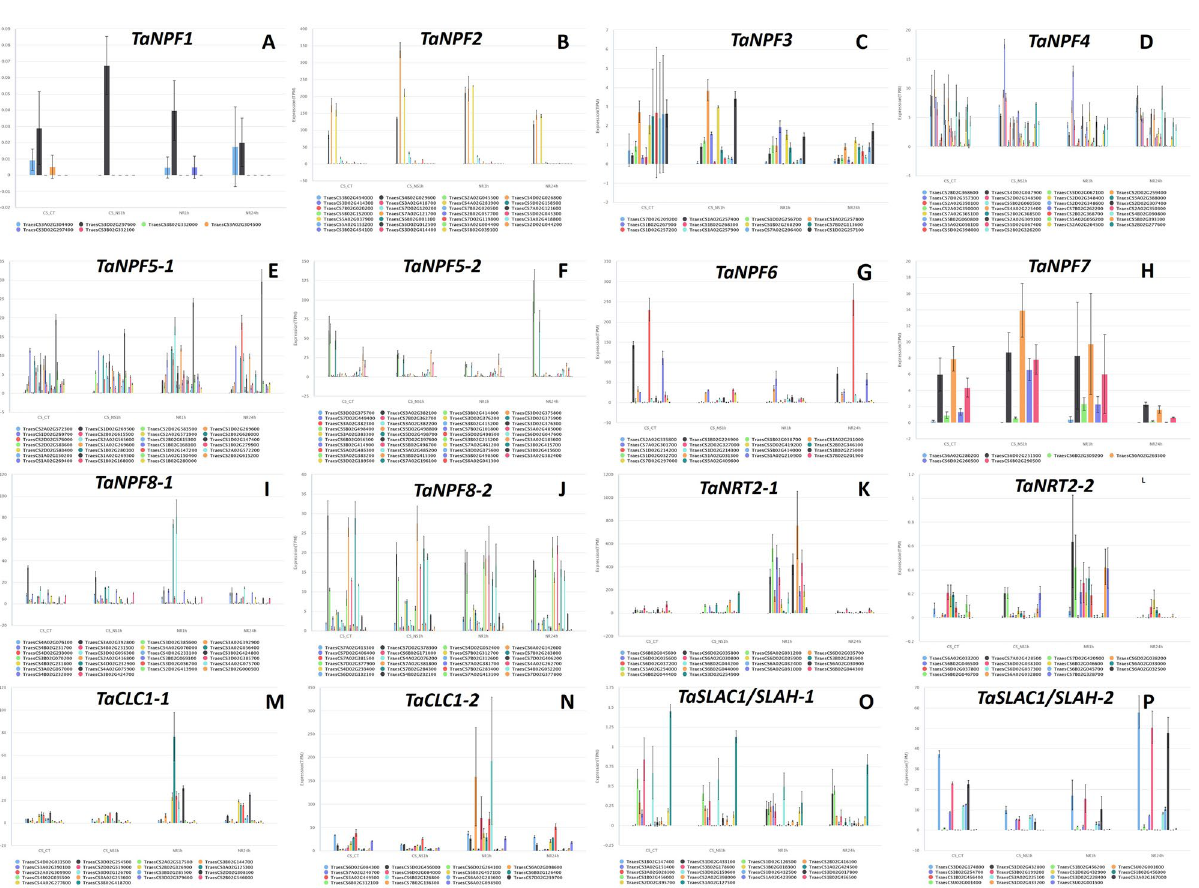
Figure 7. Expression profiles of nitrate transporter genes in response to Nitrogen starvation and Nitrogen recovery. The graphs were generated by GeneExpression tool from WheatOmics 1.0 database 47,48